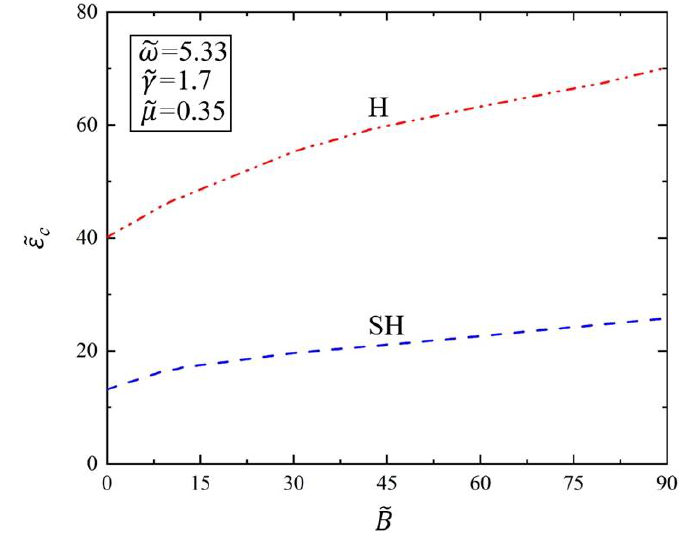
 Figure 7. Variation of the critical amplitude (cid:101) ε c of Faraday instability with the bending stiffness (cid:101) B .  of Faraday instability with the bending stiffness Figure 7. Variation of the critical amplitude c The dimensionless parameters are set as (cid:101) ω = 5.33, (cid:101) γ = 1.7, and (cid:101) µ = 0.35. The critical amplitude (cid:101) ε c  B . The dimensionless parameters are set as  . The critical increases with the increase in bending stiffness (cid:101) B .   B .  increases with the increase in bending stiffness amplitude c